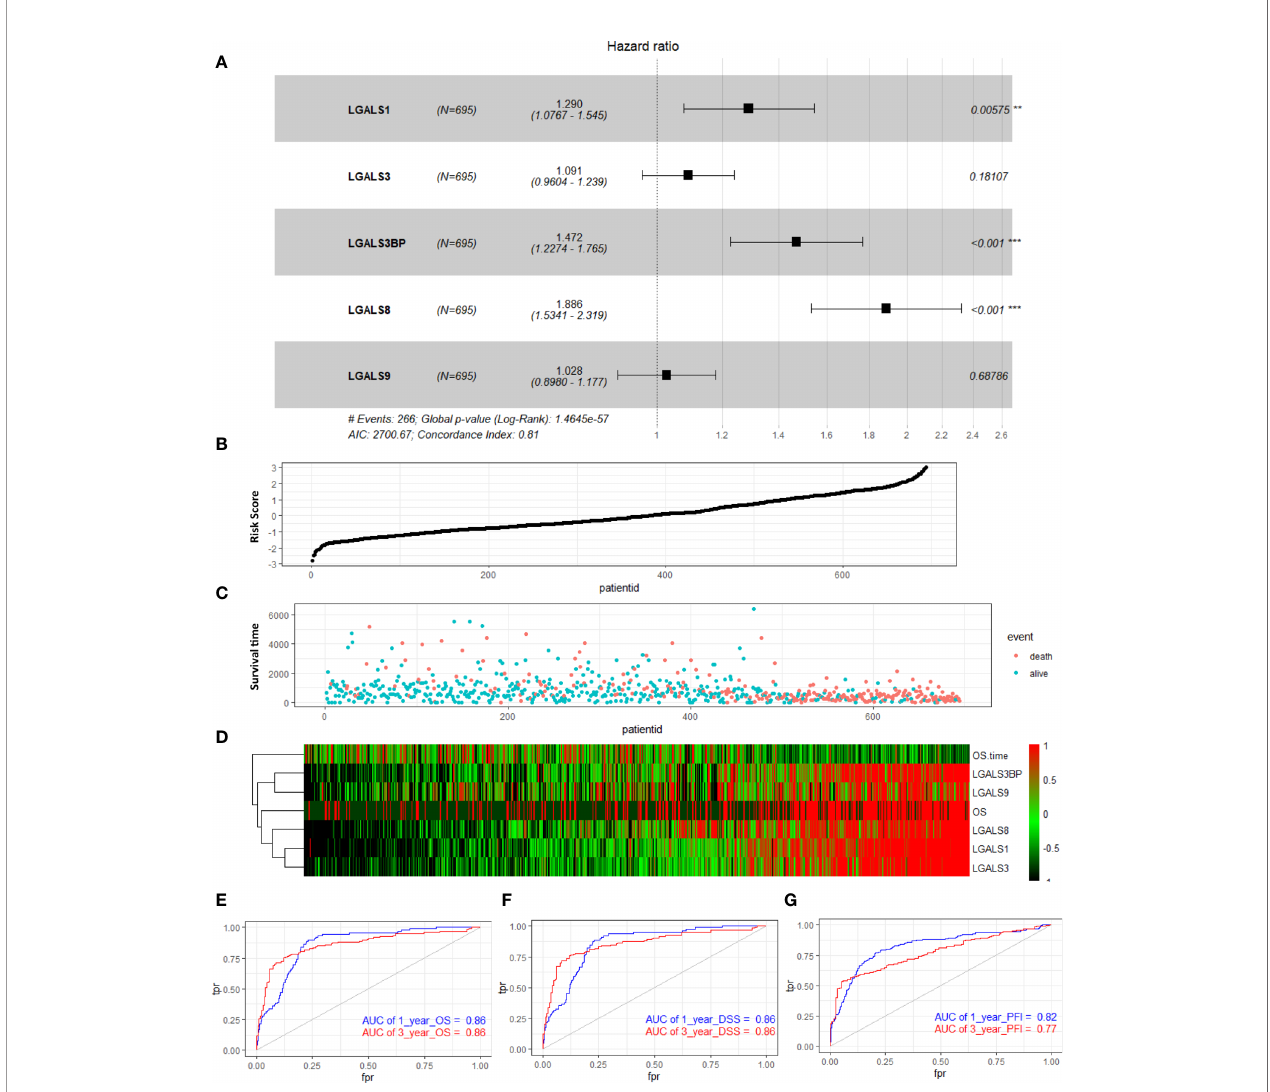
FIGURE 2 | Distribution of risk score, survival status, and risk heatmap of LGALS in patients with glioma revealed by multivariable Cox regression analysis of TCGA Glioma dataset. (A) Multivariable Cox regression analysis based on the fi ve LGALSs expressions. The black and solid squares represent the HR of death. Close- ended horizontal lines represent 95% CI. (B) The risk score curve of the LGALSs signature. (C) Patient survival status and time distributed by risk score. (D) Heatmaps of the expression levels of the 5 LGALSs and OS time of glioma patients. The colors from green to red indicate the expression level from low to high. (E – G) The prognostic performance of the LGALSs signature demonstrated by the time-dependent ROC curve for predicting the 1- and 3-year OS (E) , DSS (F), and PFI (G) rates in the TCGA Glioma dataset. TCGA, The Cancer Genome Atlas **p<0.01,